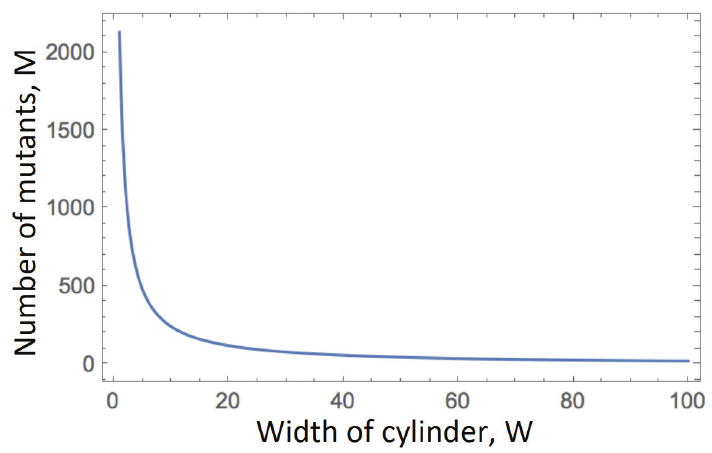
Figure 5. The number of mutants during a 2D flat front expansion decays with the front width. Equation (30) is presented with N = 10,000 and u = 5 × 10 − 5